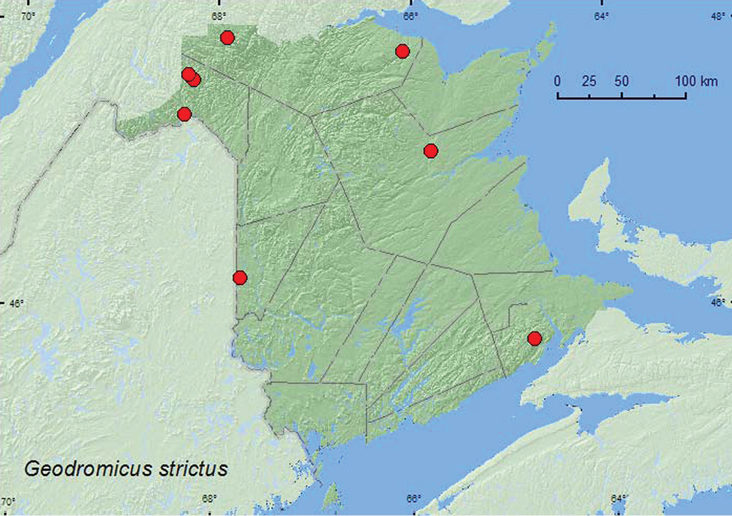
Collection localities in New Brunswick, Canada of Geodromicus strictus.